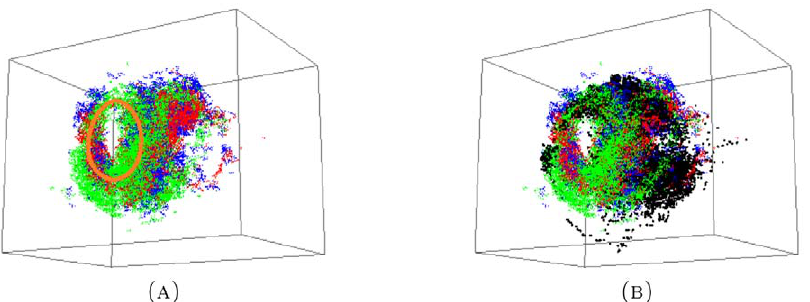
Figure 11. The experimental data for (A) long + medium + short; and (B) long + medium + short + distal. The combined set of all proximal hair afferent terminals has only one persistent generator ((A), orange), while the entire set does not have a persistent generator.